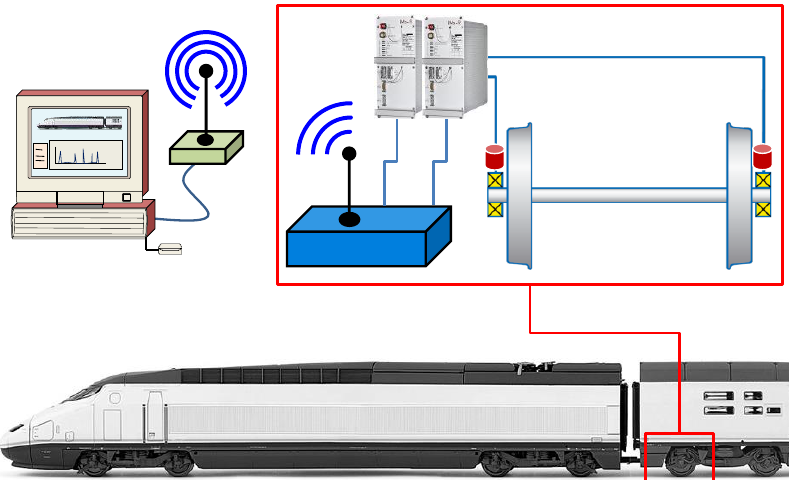
Figure 2. Diagram of the whole measurement system.